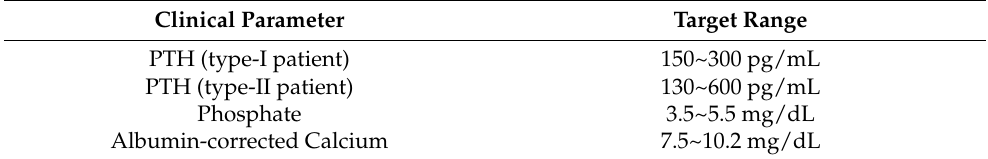
Figure 7. Mind-maps for expert-based domain models for ( a ) type-I and ( b ) type-II CKD–MBD patients along with ( c ) a sample mind-map structure for representing a CPG-based domain-model (Ca refers to albumin-corrected calcium). Table 4. Relevant clinical parameters and their target